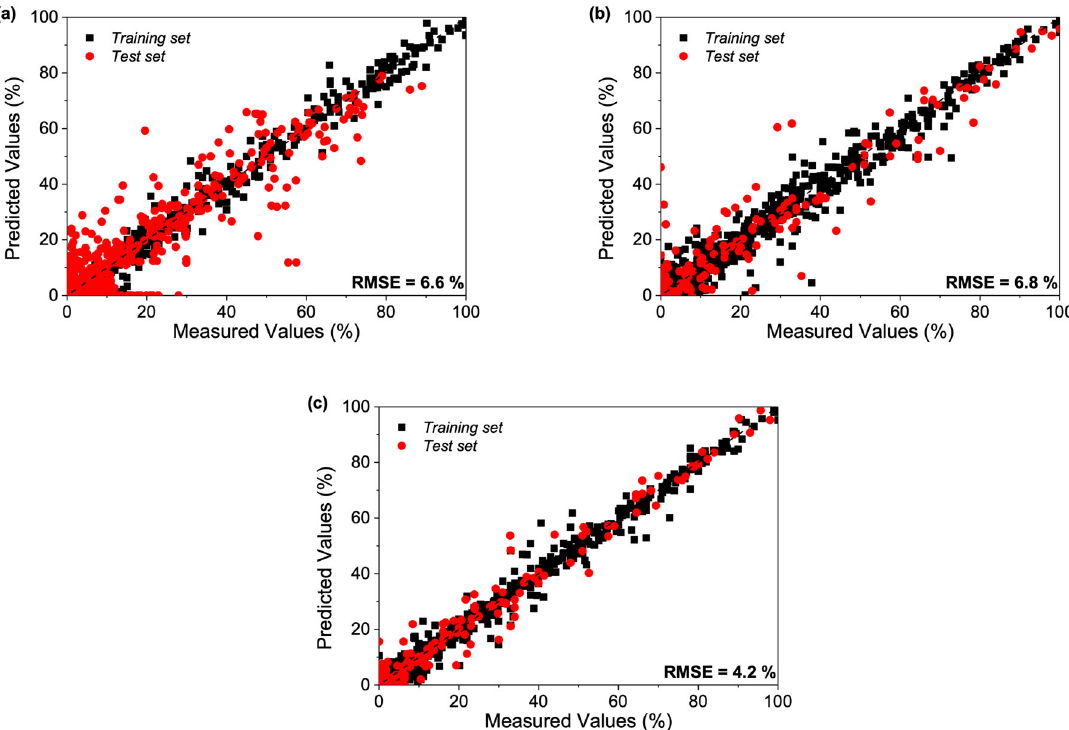
Fig. 4 Comparison of composition-structure predictions by the three different modeling approaches. a – c Experimentally measured structural values plotted against the model predictions for both the training and test sets. These structural values refer to the relative numbers of bridging and non-bridging oxygens associated with the different network formers (e.g., concentration of Q n units in the case of silicon). Black symbols present the training data, while red symbols present the test data. Model predictions are obtained using a statistical mechanics (Approach 1), b MLP-NN (Approach 2), and c a combination of statistical mechanics and MLP-NN (Approach 3). All experimentally obtained data from literature are provided and referenced in Supplementary Table